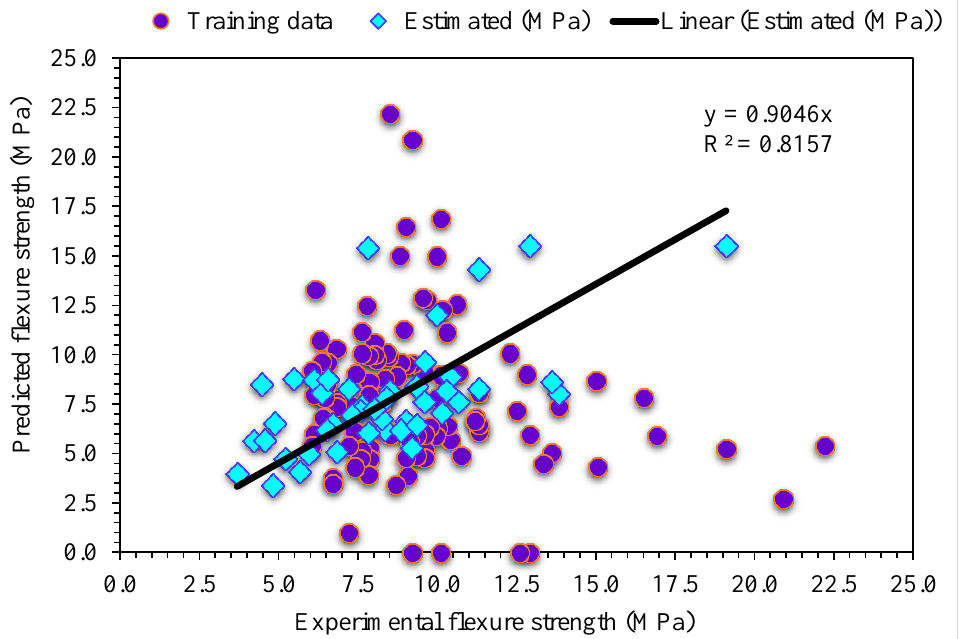
Figure 6. Experimental and MLPNN predicted results for flexural strength.